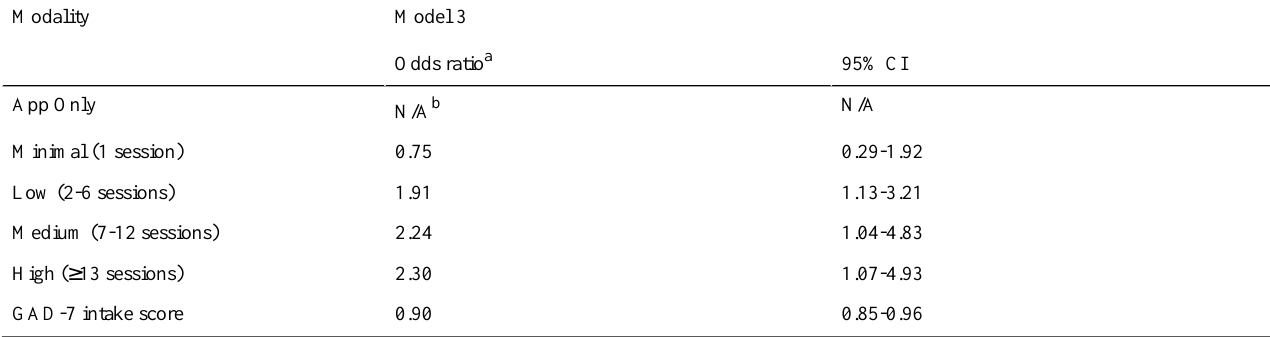
Table 5. Associations between clinical utilization and improvement among the clinical-only cohort